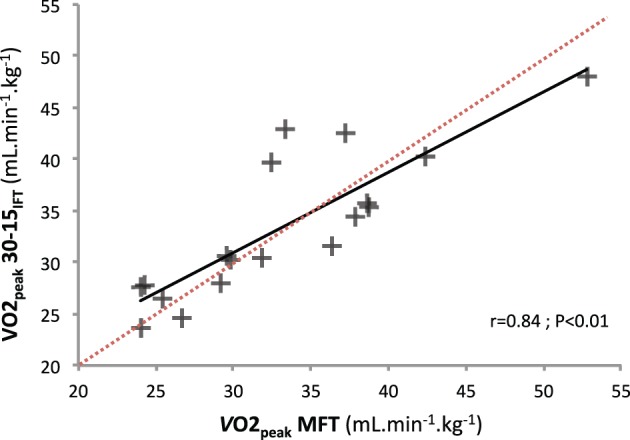
Correlation between VO2peak reached during MFT and 30-15IFT tests (r = 0.54, r2 = 0.71, P < 0.01).